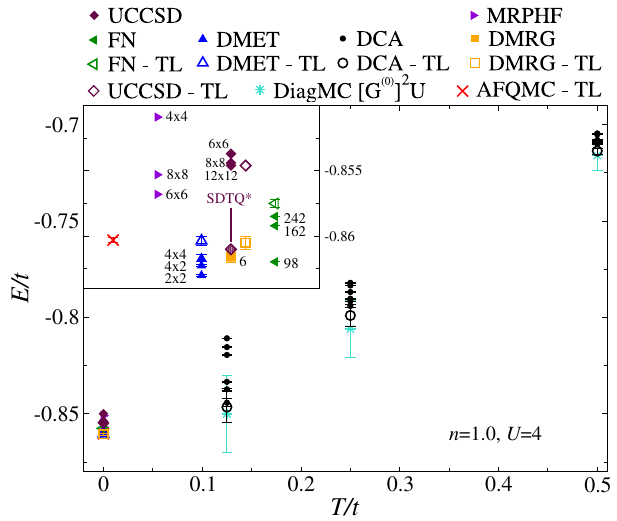
FIG. 9. Data for n ¼ 1 for U=t ¼ 4 . Main panel: Temperature dependence of E=t compiled from various techniques. Solid symbols represent finite systems; open symbols represent extrap- olations to the thermodynamic limit. Finite- T results are shown for DCA (black circles) and DiagMC (turquoise stars), and zero- T data from AFQMC (red crosses), DMET (blue triangles), UCCSD (maroon diamonds), MRPHF (purple triangles), DMRG (orange squares), and FN (green triangles). Top left inset: Zoom- in of the zero- T data from MRPHF, DMET, FN, DMRG, and AFQMC, including finite-system-size data (as labeled) for MRPHF, FN, DMRG, and DMET.